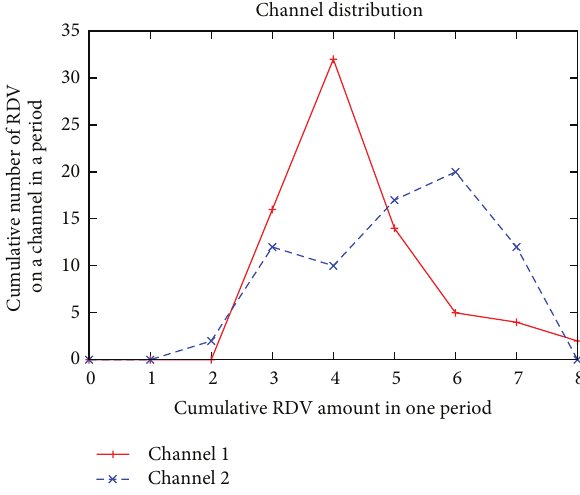
Figure 17: DSMMAC [13]: the combination of maps with 2 and 8 channels (73